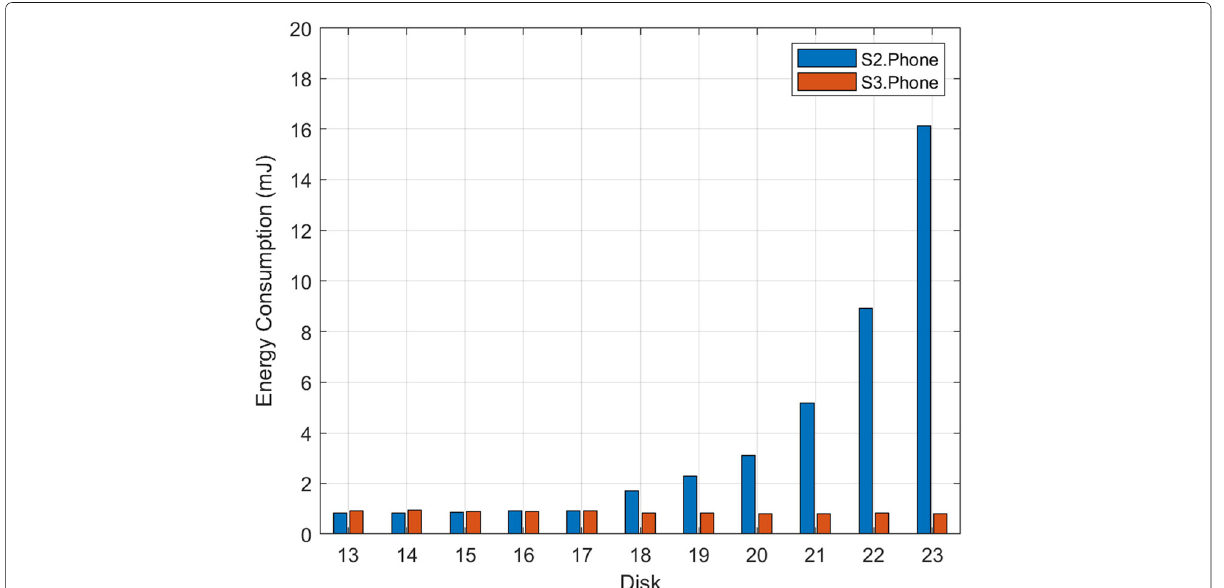
Fig. 9 Comparison of energy consumption of Smartphone according to number of disks